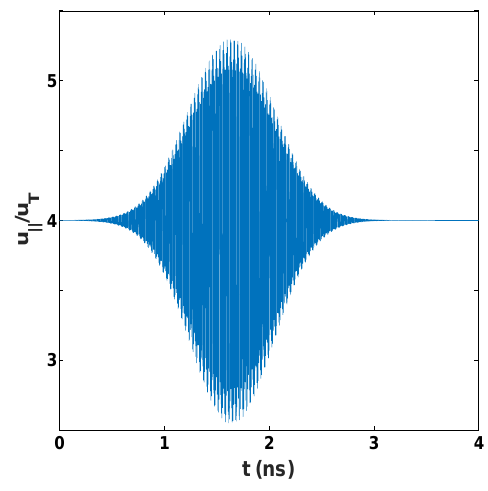
Figure 1. The evolution of u ∥ / u T as a function of time. The initial position of the electron is outside the beam and it is moving along the positive z direction. The Gaussian beam has the polarization of the ordinary EC wave and power of 1MW. The other parameters are as indicated in the text.